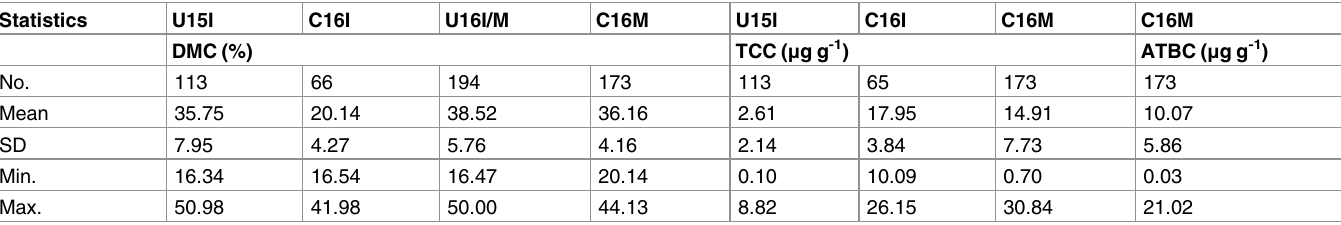
Table 1. Description of calibration sets developed at NRCRI Umudike, Nigeria and CIAT, Cali Colombia in 2015 and 2016 on intact and mashed root samples. Carotenoids(TCC and ATBC) data are on a fresh weight basis.